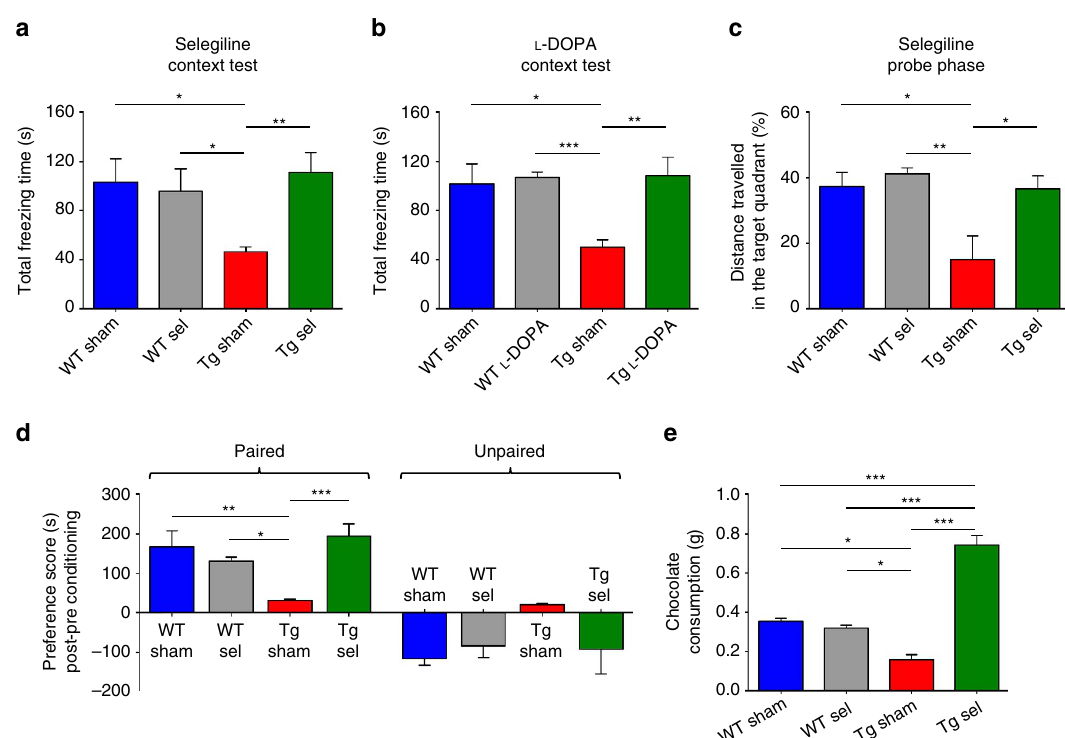
Figure 7 | Sub-chronic selegiline or L -DOPA treatment rescues memory performance and reward processing in Tg2576 mice. ( a , b ) Total freezing time during the CFC context test in 6-month-old sham- and sel-treated mice ( a ; 6 mice per group) and in sham- and L -DOPA-treated mice ( b ; 5 mice per group). Both drugs restore contextual fear memory in Tg2576 mice ( a : two-tailed unpaired t -test: WTsham-Tg sham * P ¼ 0.015, WTsel-Tg sham * P ¼ 0.025, Tg sham-Tg sel ** P ¼ 0.004; ( b ): two-tailed unpaired t -test: WT sham-Tg sham * P ¼ 0.018, WT L -DOPA-Tg sham *** P ¼ 1.30 (cid:3) 10 (cid:2) 4 , Tg sham-Tg L -DOPA ** P ¼ 0.007). ( c ) Percentage of distance travelled in the target quadrant (previously containing the platform) during the Probe phase of the MWM test for 6-month-old sham- and sel-treated mice ( n ¼ 5 mice per group). Tg sham mice swam less in the target quadrant in comparison to the remaining groups, while selegiline was able to restore spatial memory performance (two-tailed unpaired t -test: WTsham-Tg sham * P ¼ 0.030, WTsel-Tg sham ** P ¼ 0.008, Tg sham-Tg sel * P ¼ 0.031). ( d ) Chocolate-induced place preference in 6-month-old sham- and sel-treated mice ( n ¼ 4 WTsham, 4WTsel, 4 Tg sham and 6 Tg sel mice) showing mean time spent in paired and unpaired chambers in post-conditioning session, minus the time spent in the same chambers during the pre-conditioning session of a CPP test (two-way repeated measures ANOVA: chamber, F 1,14 ¼ 36.97, P o 1.00 (cid:3) 10 (cid:2) 4 ; chamber (cid:3) treatment, F 3,14 ¼ 231.34, P o 0.050; treatment, F 3,14 ¼ 0.50, P ¼ 0.680; WT sham-Tg sham ** P o 0.010, WT sel-Tg sham * P o 0.050, Tg sham-Tg sel *** P o 0.001 with Tukey’s post hoc test). ( e ) Chocolate consumption during conditioning sessions of the CPP test shown in d (one-way ANOVA: F 3,14 ¼